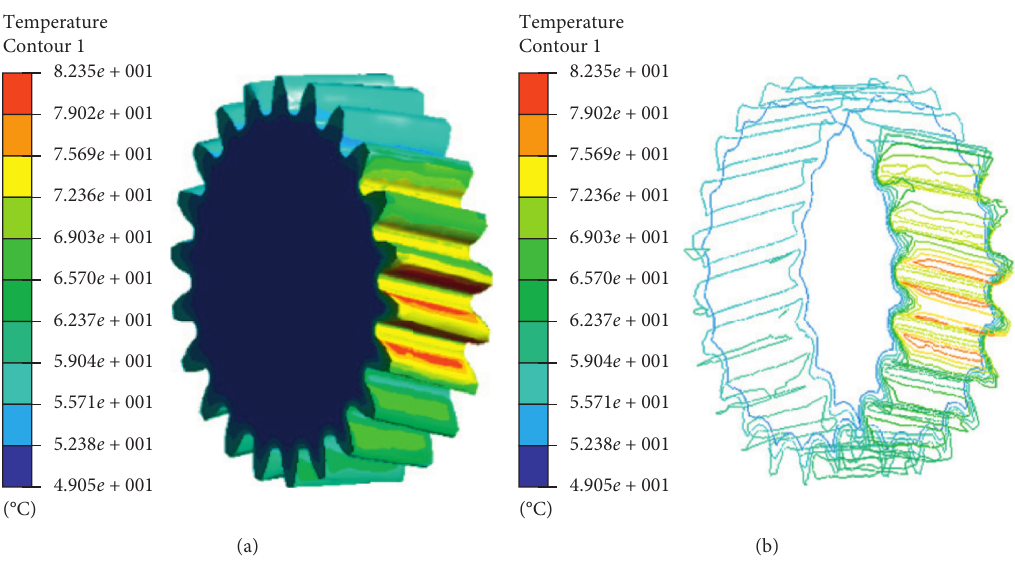
Figure 16: The transient temperature nephogram and temperature isogram chart.